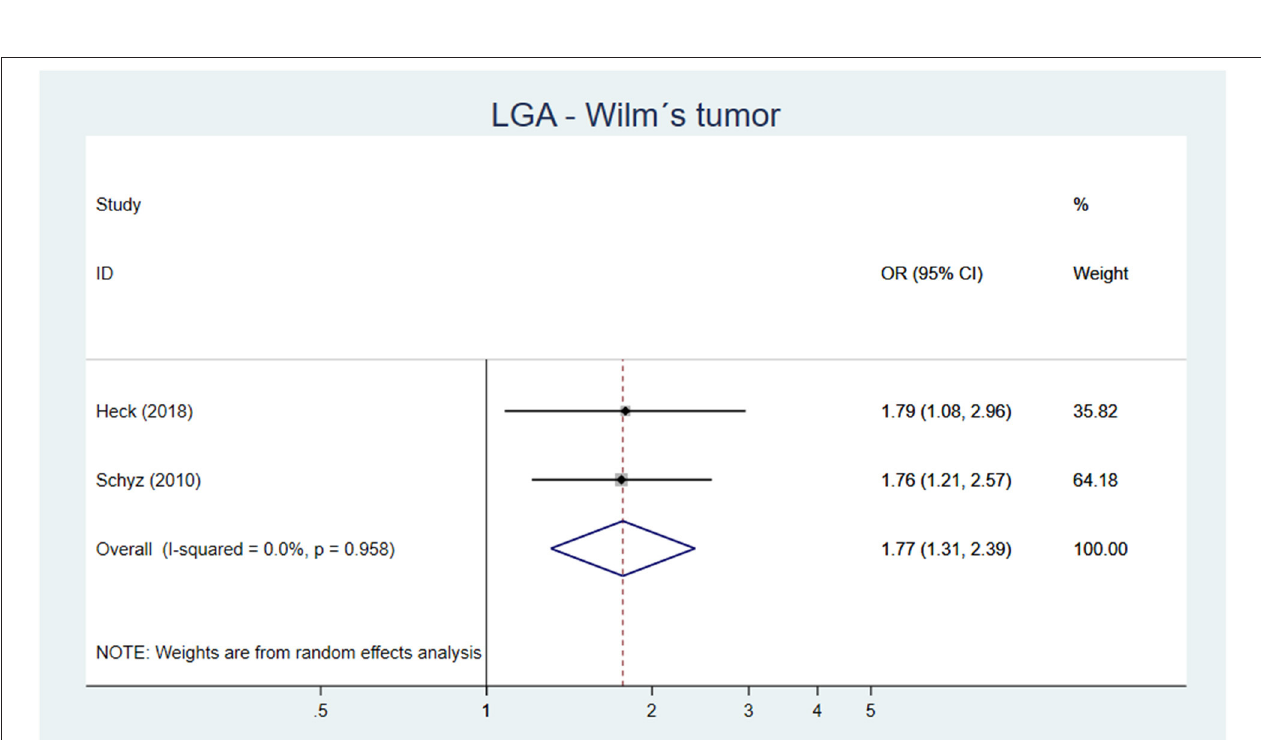
FIGURE 7 | Forest plot describing the association between high birth weight and Wilm’s tumor.